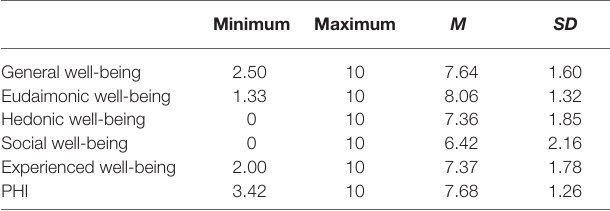
TABLE 1 | Descriptive statistics of happiness